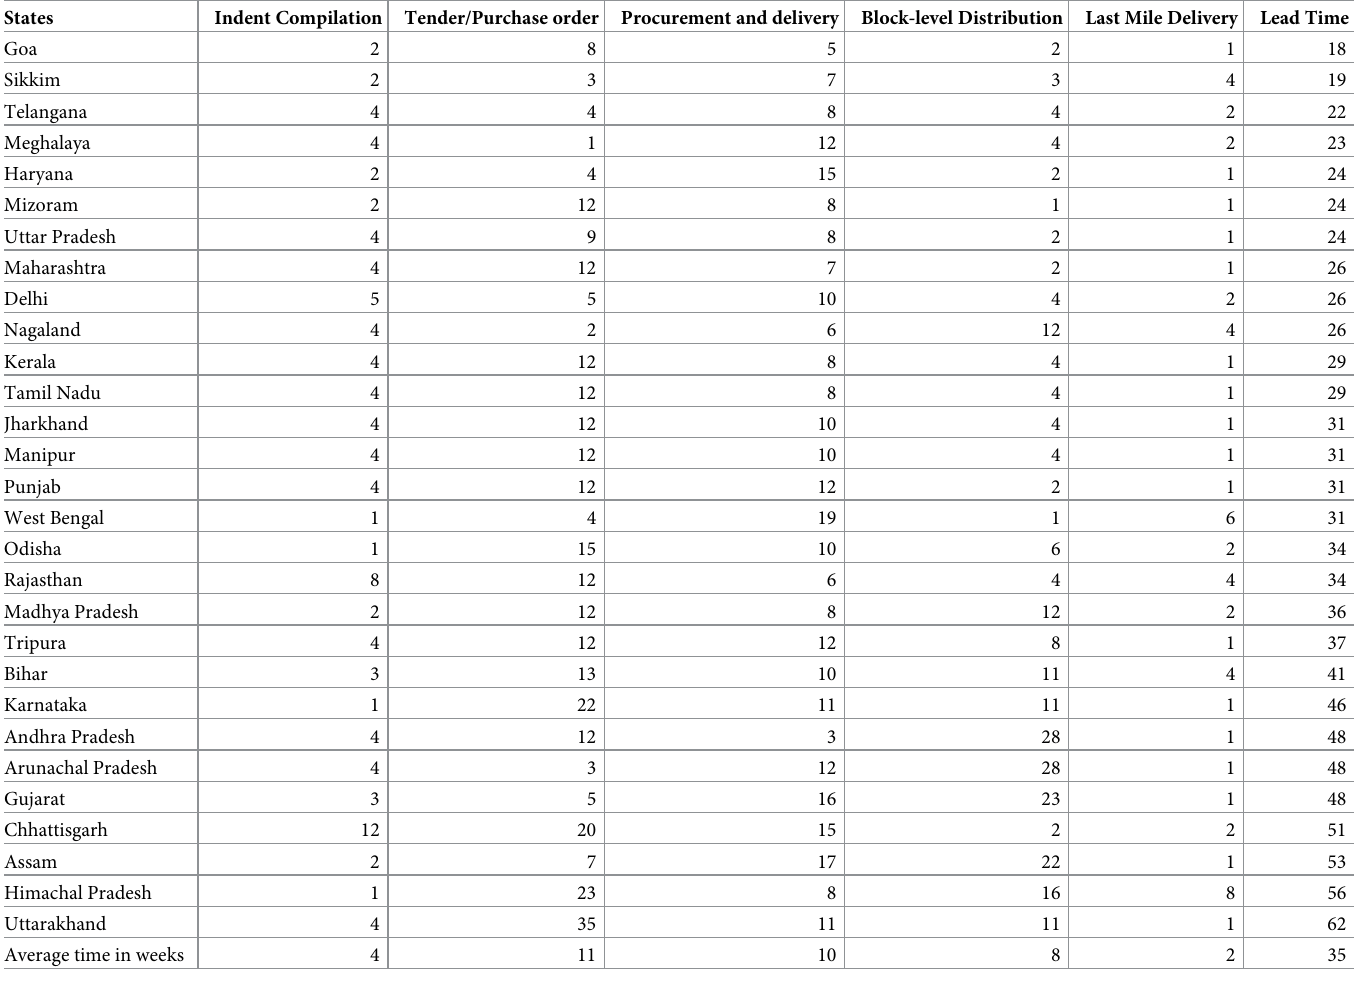
Table 2. Lead time index (in weeks) for IFA supplements supply chain by states / UTs, 2018–19.